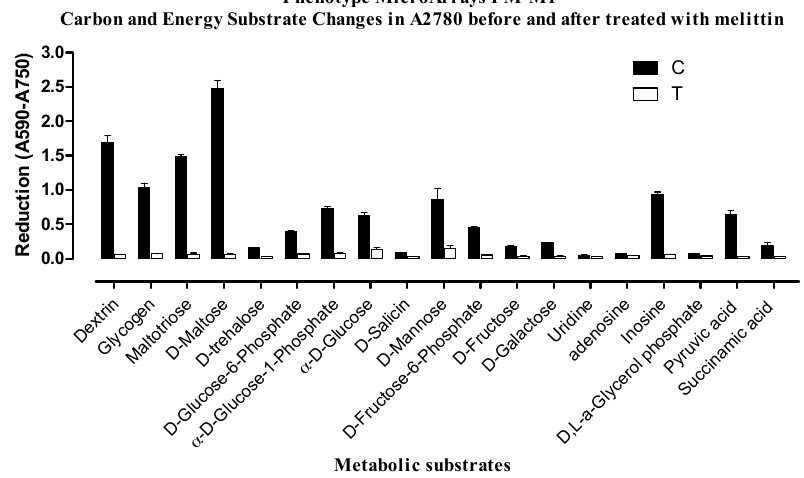
Figure 3. Comparison of substrate metabolism in A2780 cells following melittin exposure. Dye reduction rates calculated following 24 h incubation of cells with melittin at IC 50 (6.8 μ g/mL) concentration. C = untreated controls; T = melittin treated.